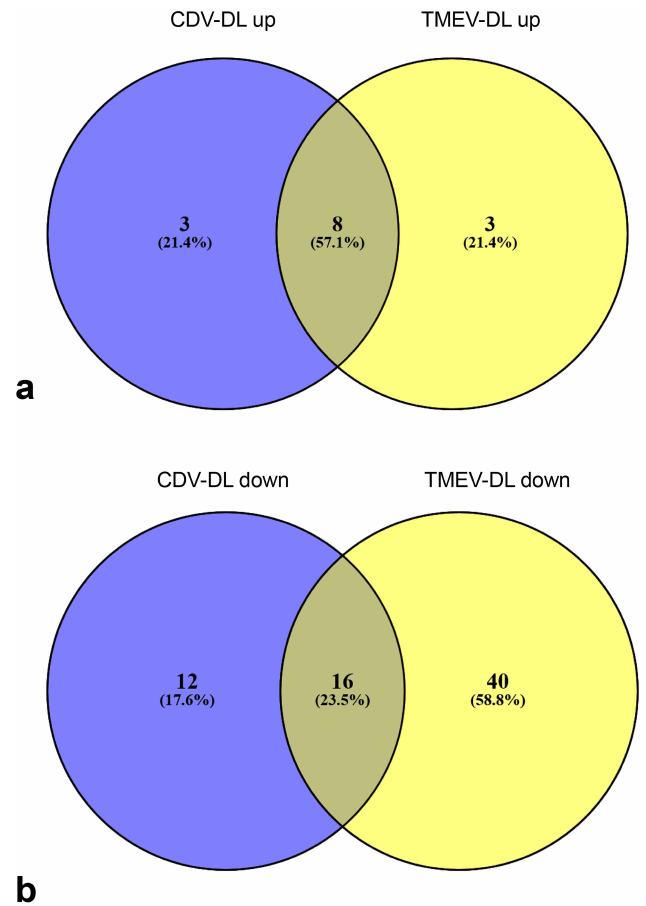
Figure 11. Venn diagrams comparing the di ff erentially expressed genes (DEGs) of a manually generated list of genes implicated in the generation and detoxification of ROS-metabolites in CDV DL and TMEV infected mice: ( a ) the Venn diagram display the number and intersections of upregulated DEGs in CDV leukoencephalitis and TMEV infected mice, respectively. The three genes included exclusively in CDV-DL were: UQCRC2, SOD1, and SOD2. The three genes included exclusively in “TMEV-DL up” were GPX3, NCF1, and SOD3. ( b ) the Venn diagram display the number and intersections of downregulated DEGs in CDV leukoencephalitis and TMEV infected mice,